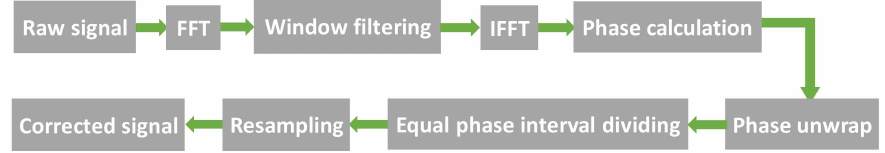
Figure 6. Procedure for the self-reference method for the laser tuning nonlinearity